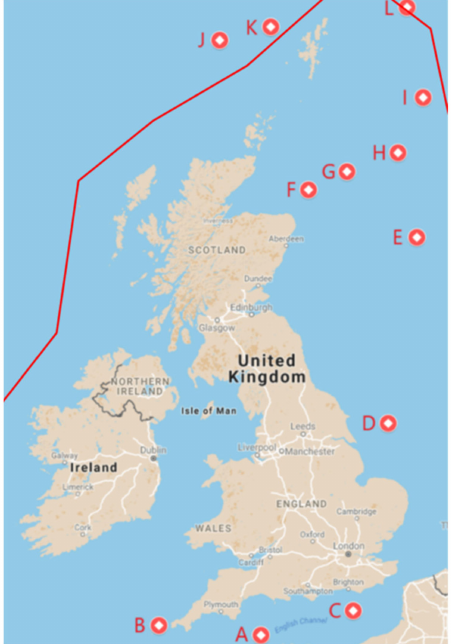
Figure 6. Map of the 12 wind data point locations. Letters used to differentiate between sites. Adapted